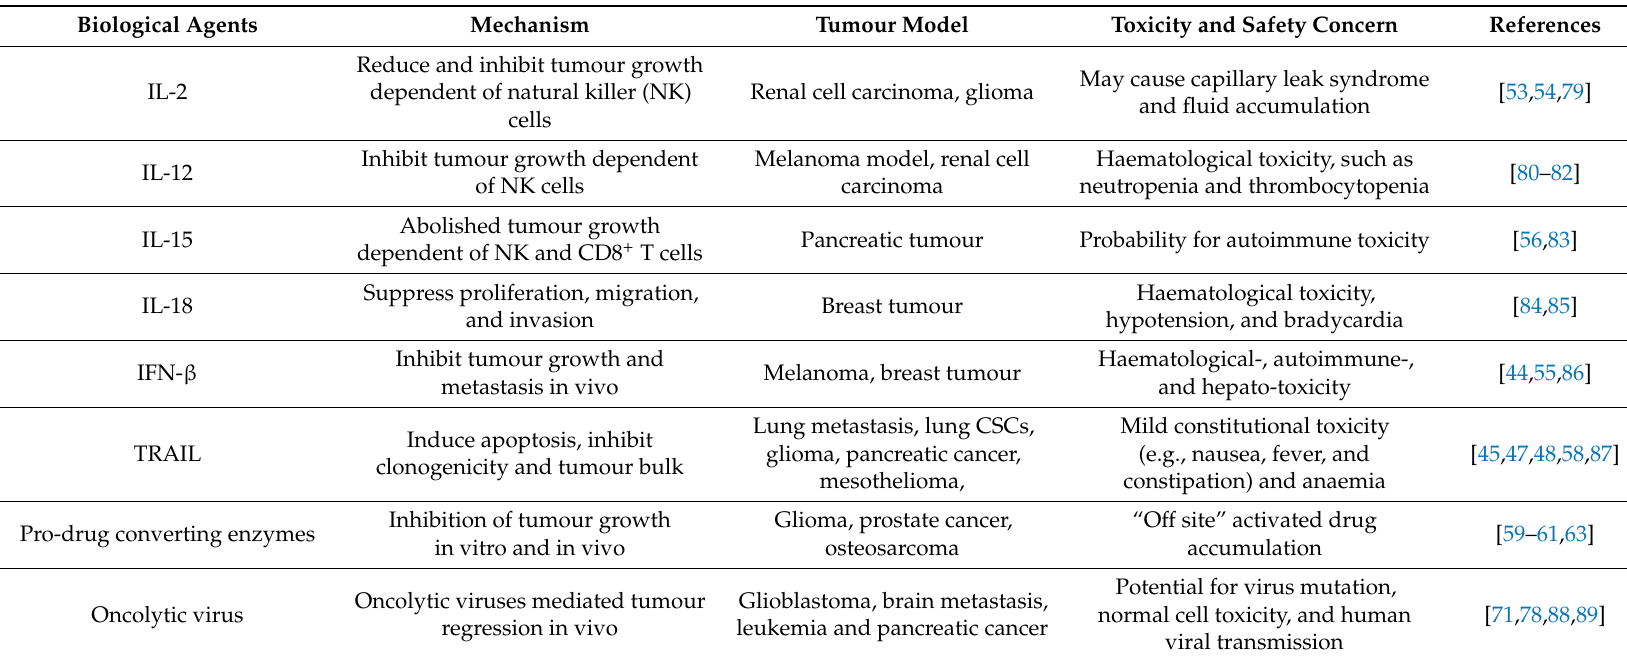
Table 1. Biological agents utilizing engineered mesenchymal stem cells (MSCs) as vehicle for ligand delivery and its safety. TRAIL—tumour necrosis factor-related apoptosis inducing ligand; CSCs—cancer stem cells; IFN— interferon;